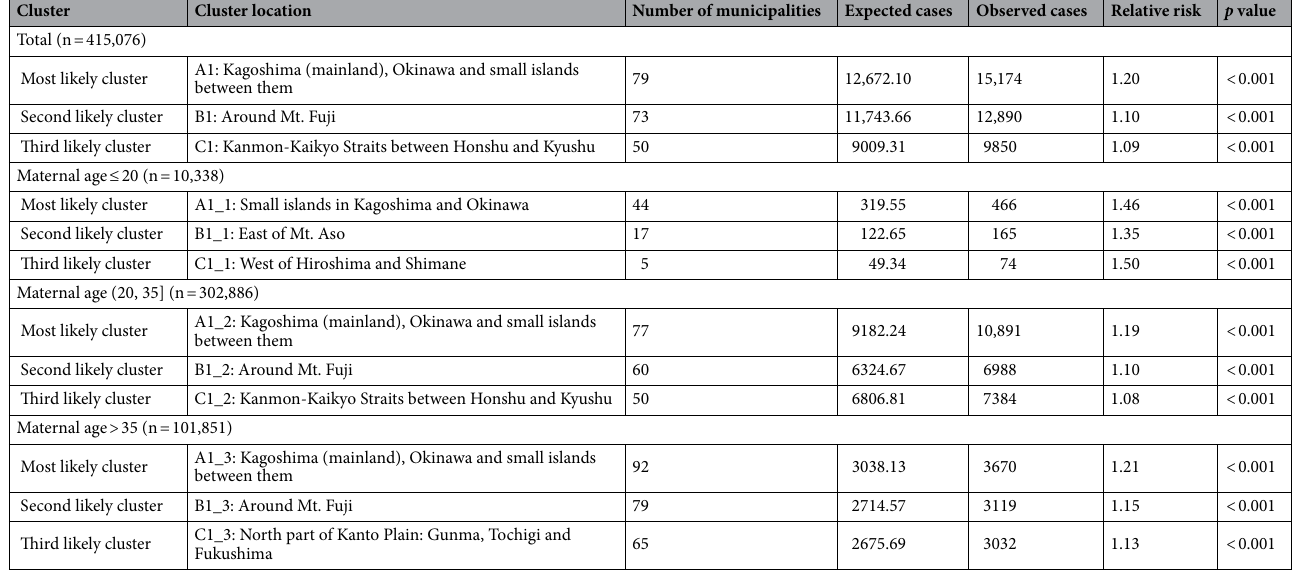
Table 2. Geographical clusters of LBW in Japan.